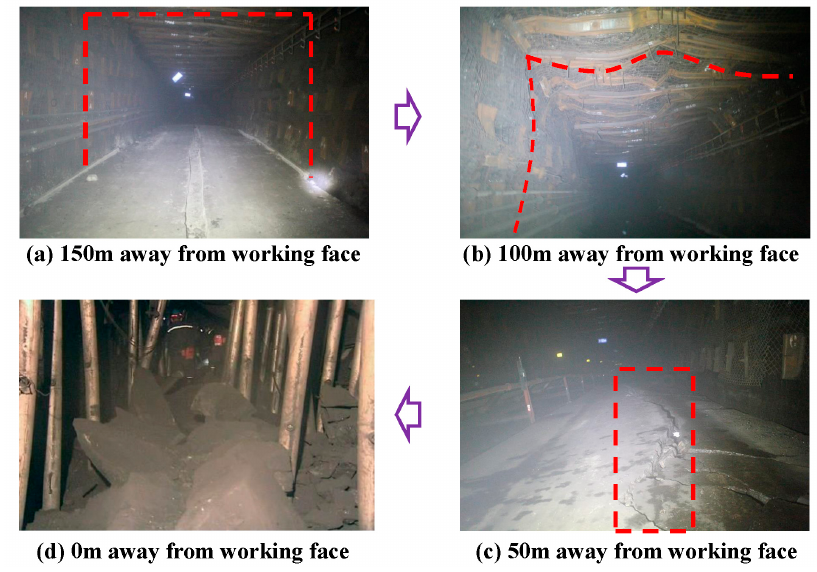
Figure 13. Process of rock deformation in 8107 roadways.